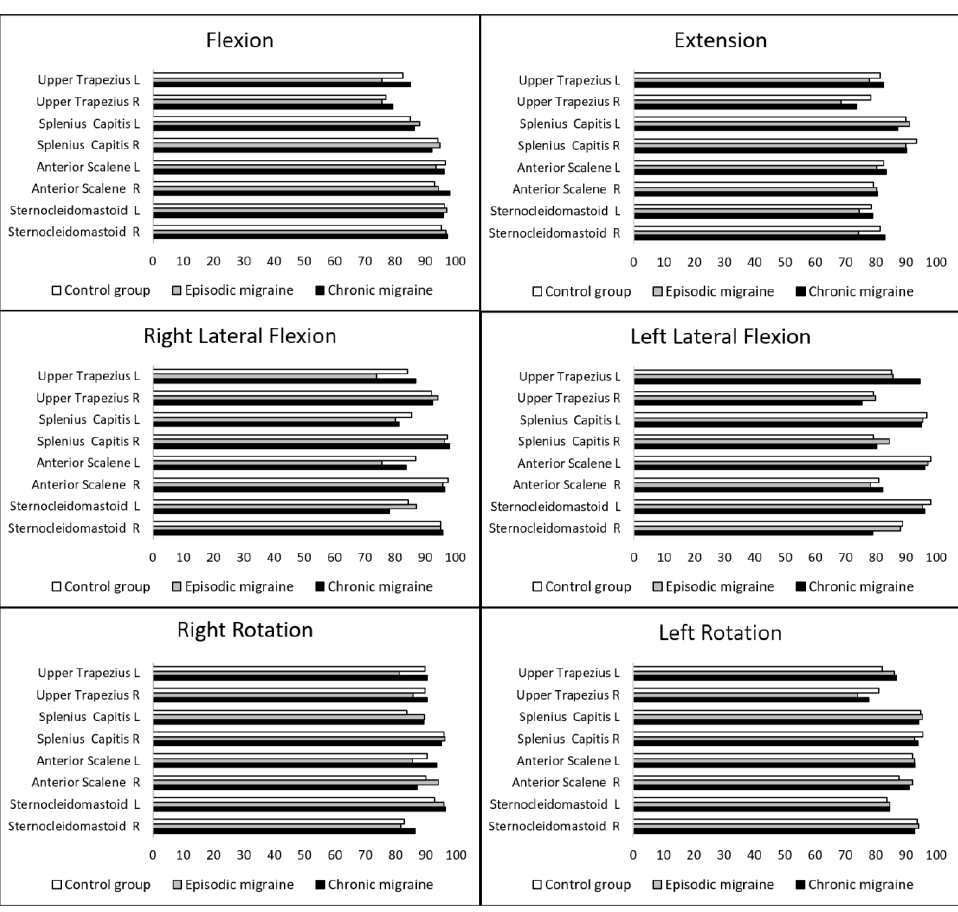
Figure 2. Mean percentage of activation of cervical muscles during active neck movements. R: right ; L: left